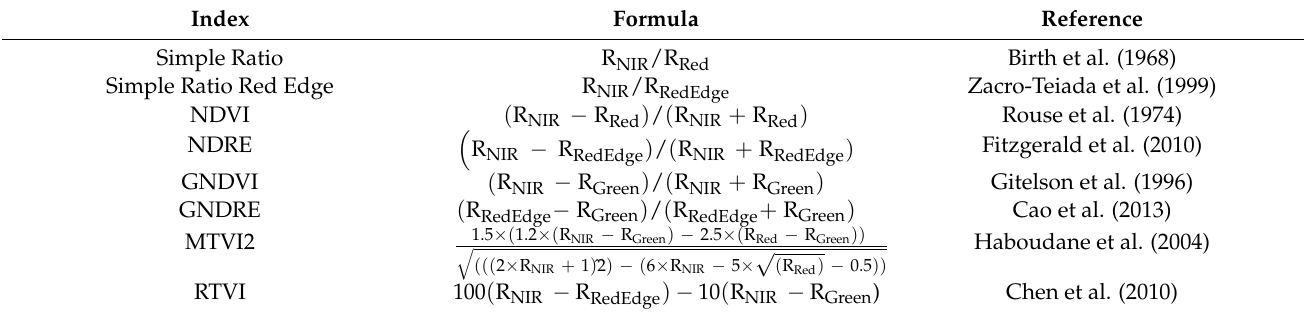
Table 3. Vegetation indices formulas and